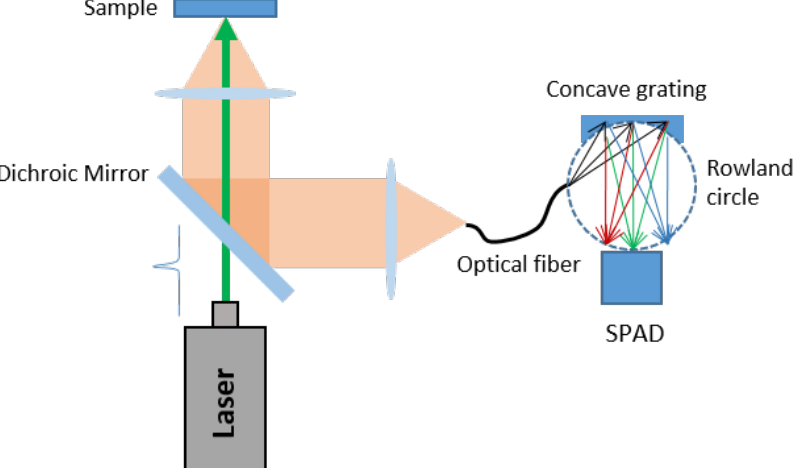
Figure 17. Optical diagram of the proposed TG Raman spectrometer reported in